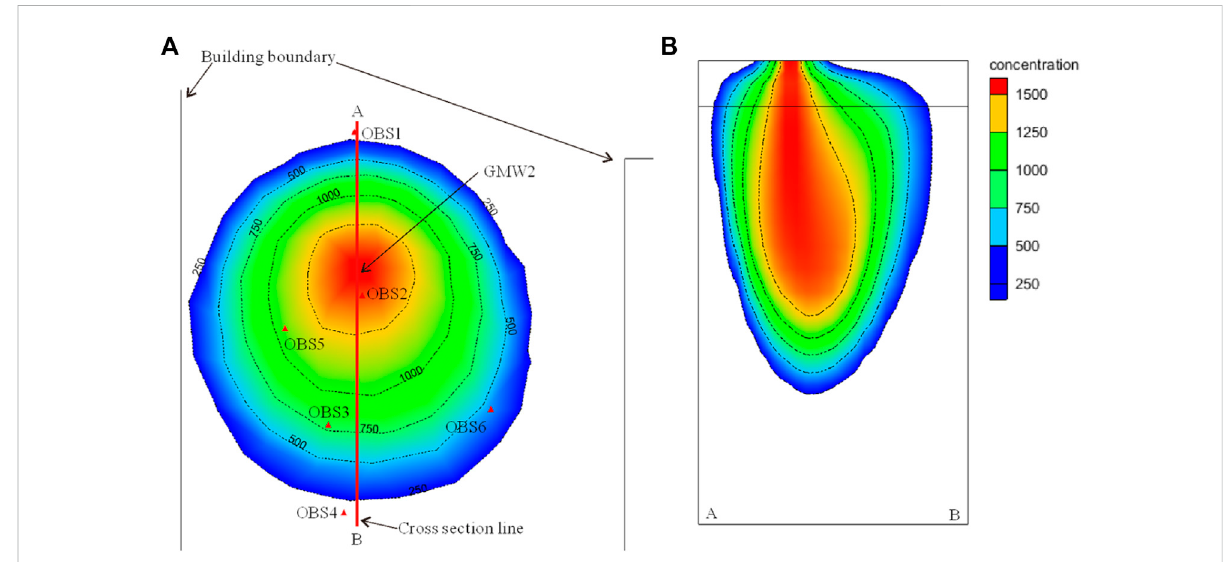
FIGURE 9 Prediction results of chloride ions concentration: (A) plane distribution; (B) vertical